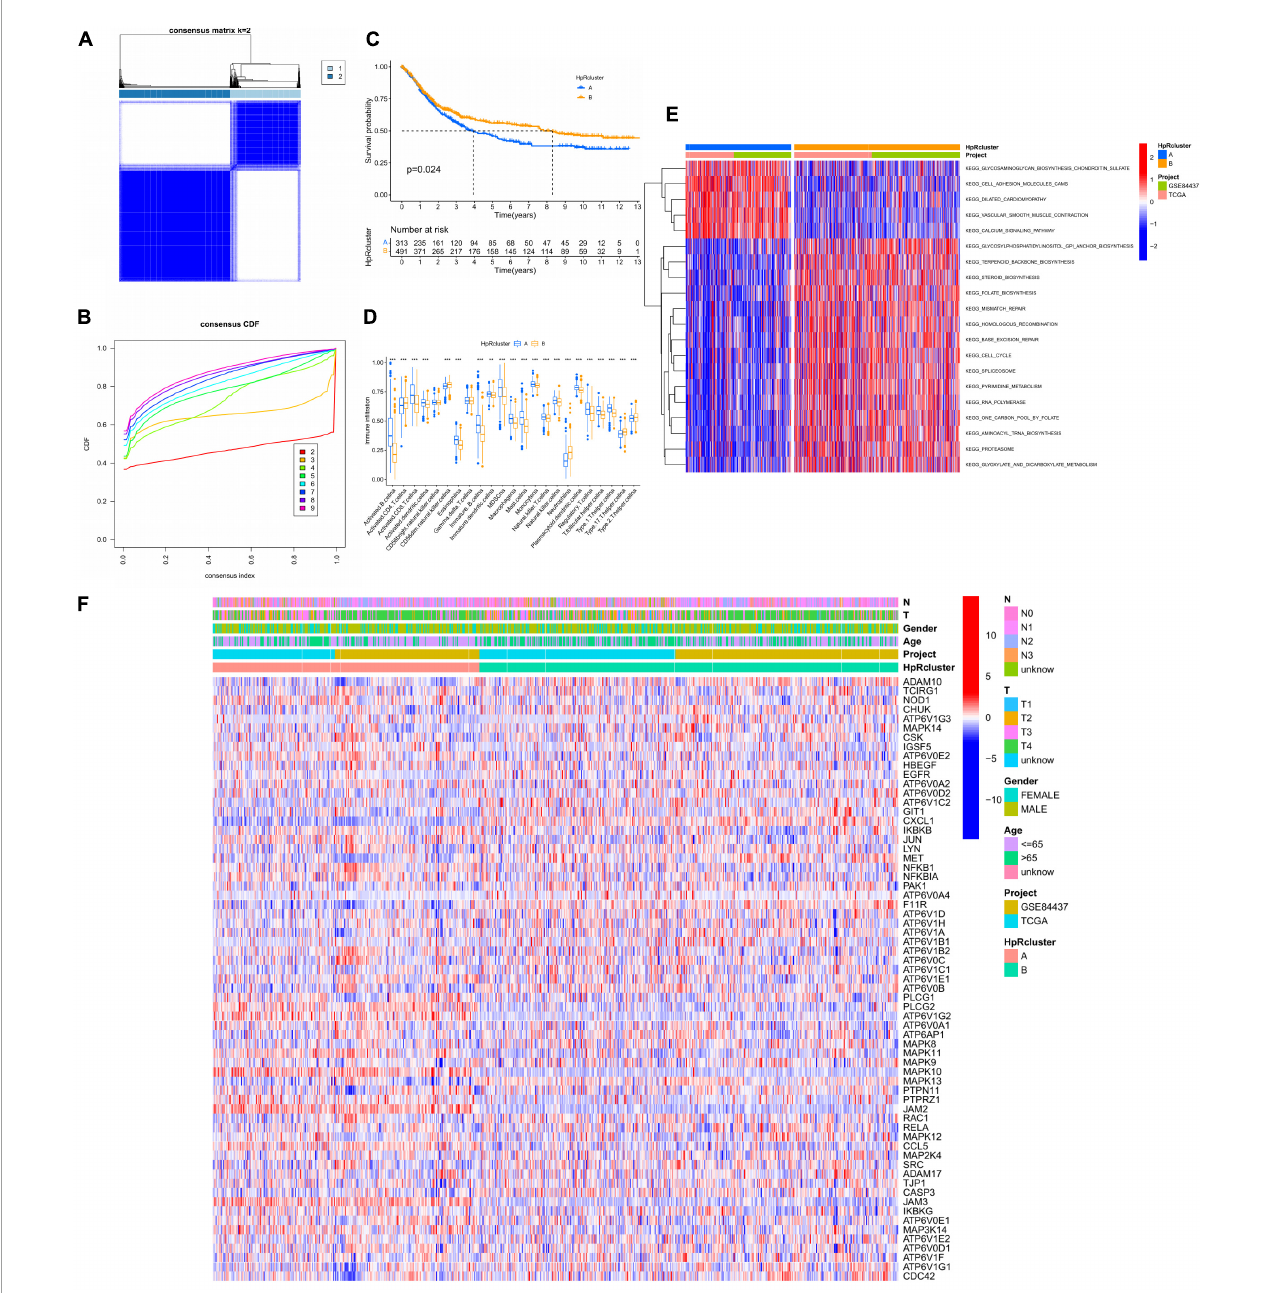
FIGURE4 HP-related genes (HRGs) subtypes, clinicopathological and TME characteristics of subtype A and B classified by consensus clustering analysis. (A) Heatmap of consensus matrix ( k = 2) showing the relative area of each cluster. (B) The CDF curves revealing the consensus distributions according to the k value. (C) Univariate analysis presenting 52 HRGs related to respective RFS time. (D) Immune infiltration level of 23 immune cells in subtype A and B, * p < 0.05, ** p < 0.01, and *** p < 0.001. (E) GSVA between subtype A and B. Red represented activated pathways while blue represented suppressive pathways. (F) Distinct clinicopathological characteristics and expression levels of HRGs on account of different clusters. HRGs, HP-related genes; TME, tumor microenvironment; CDF, cumulative distribution function; GC, gastric cancer; RFS, recurrence-free survival; GSVA, gene set variation